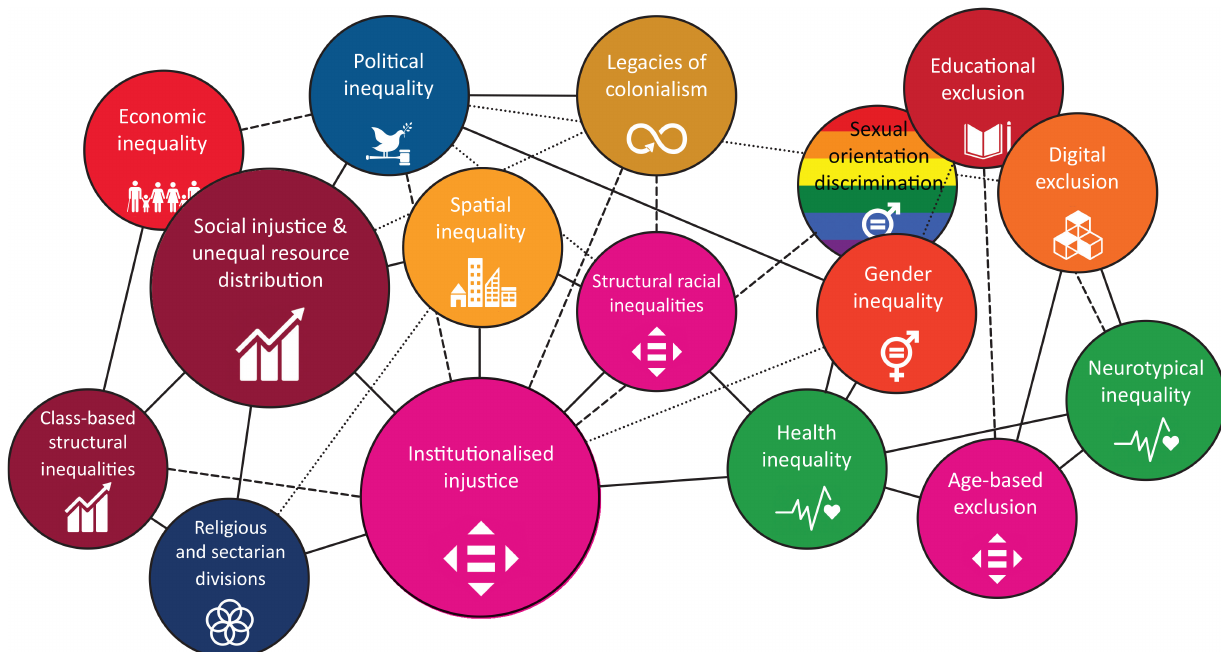
Figure 1. Dimensions of inequality “mapped” against the UN SDGs.